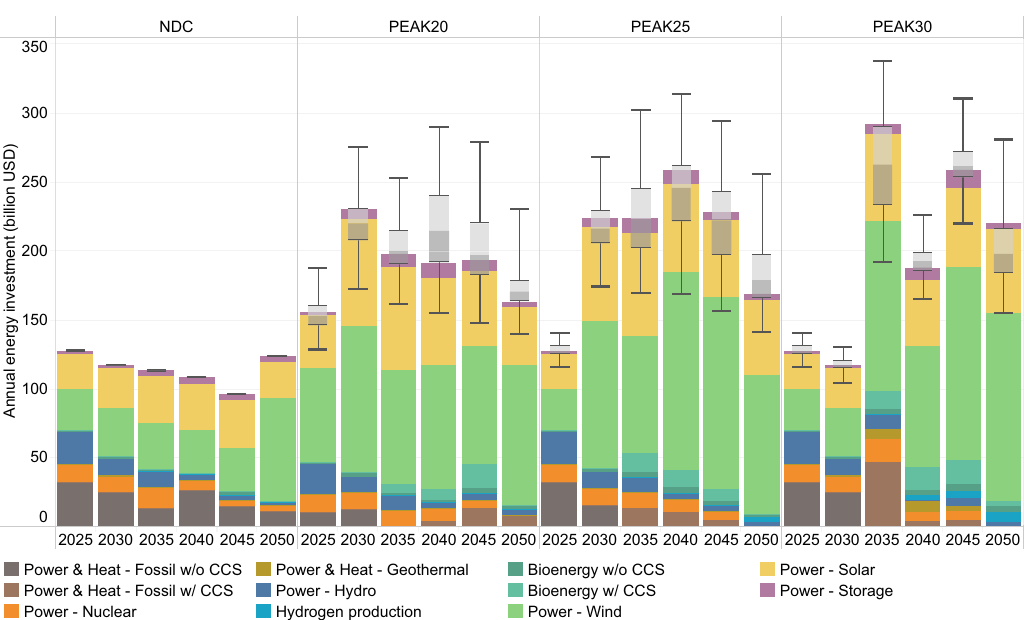
Fig. 8 Annual investment in energy supply (unit: billion US dollars). The annual investment in biomass utilization, hydrogen production, energy storage, fossil fuel power generation and heating, solar power generation, wind power generation, and other renewable energy power generation from 2020 to 2050 for the intermediate case in each scenario is shown in the stacked bar chart. The box plot represents the uncertainty range of annual total energy supply investment. The box plot shows the fi rst quantile, intermediate range (IQR), and third quantile of all the results, where the data range within 1.5 times the IQR is denoted with whiskers. The uncertainty in the cumulative investment for each type of technology for 2010 – 2050 is presented in Supplementary Fig. 17. In this fi gure, w/ CCS means that this technology is equipped with carbon capture and storage, while w/o CCS means that it is not